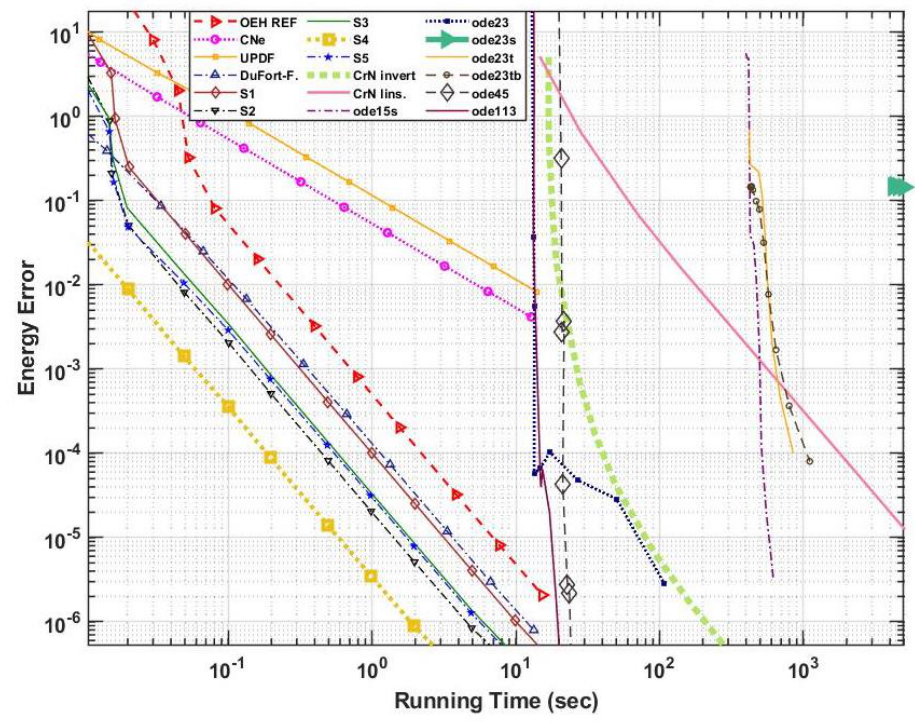
Figure 5. Energy errors as a function of the running time for the first (moderately stiff) system, in the case of the original OEH method (OEH REF), one-stage CNe and UPFD methods, the Dufort–Frankel method, the new Algorithms S1–S5, and the Crank–Nicolson with two implementations and different MATLAB routines. Table 1. Comparison of different algorithms for the moderately stiff system of 10,000 cells.